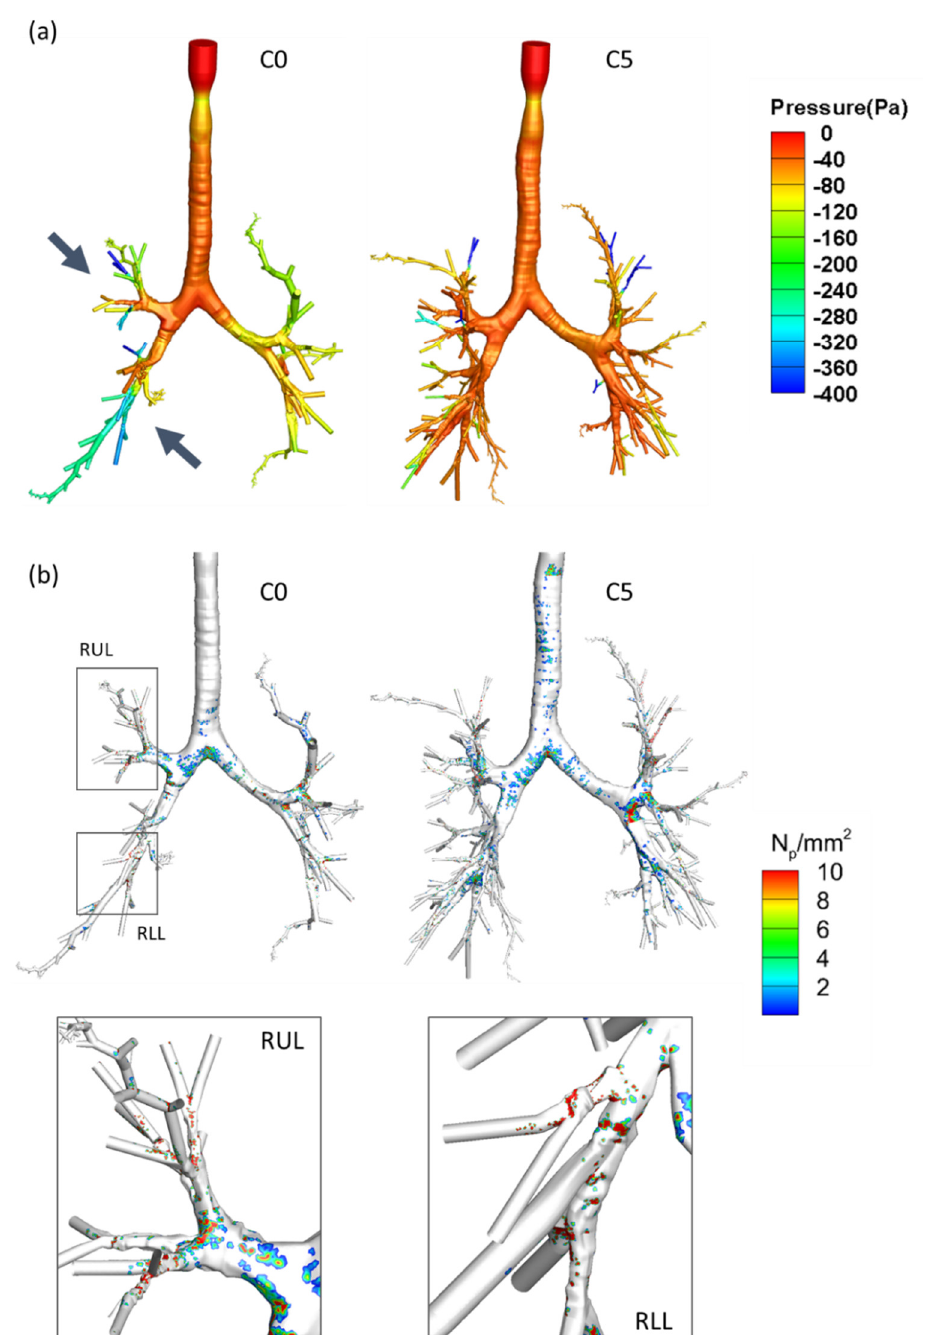
Figure 9. ( a ) Peak inspiratory pressure distributions in the airways. The arrows represent the greater pressure drop in the C0 representative subject. ( b ) Color maps of the particle deposition density on the airway wall surface (N p /mm 2 ). Hotspots were found in the segmental airways of RUL and RLL in the C0 representative subject.